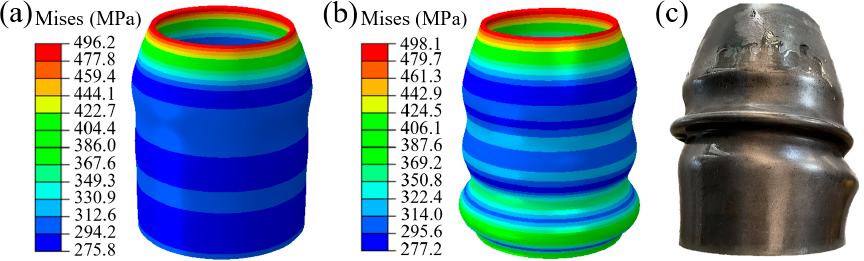
Figure 18. Wrinkles in XOY plane during TUBG process with a pressure of 20 MPa. ( a ) The emergence of wrinkle, ( b ) The evolution of the wrinkles ,( c ) The wrinkle morphology after the experiment.